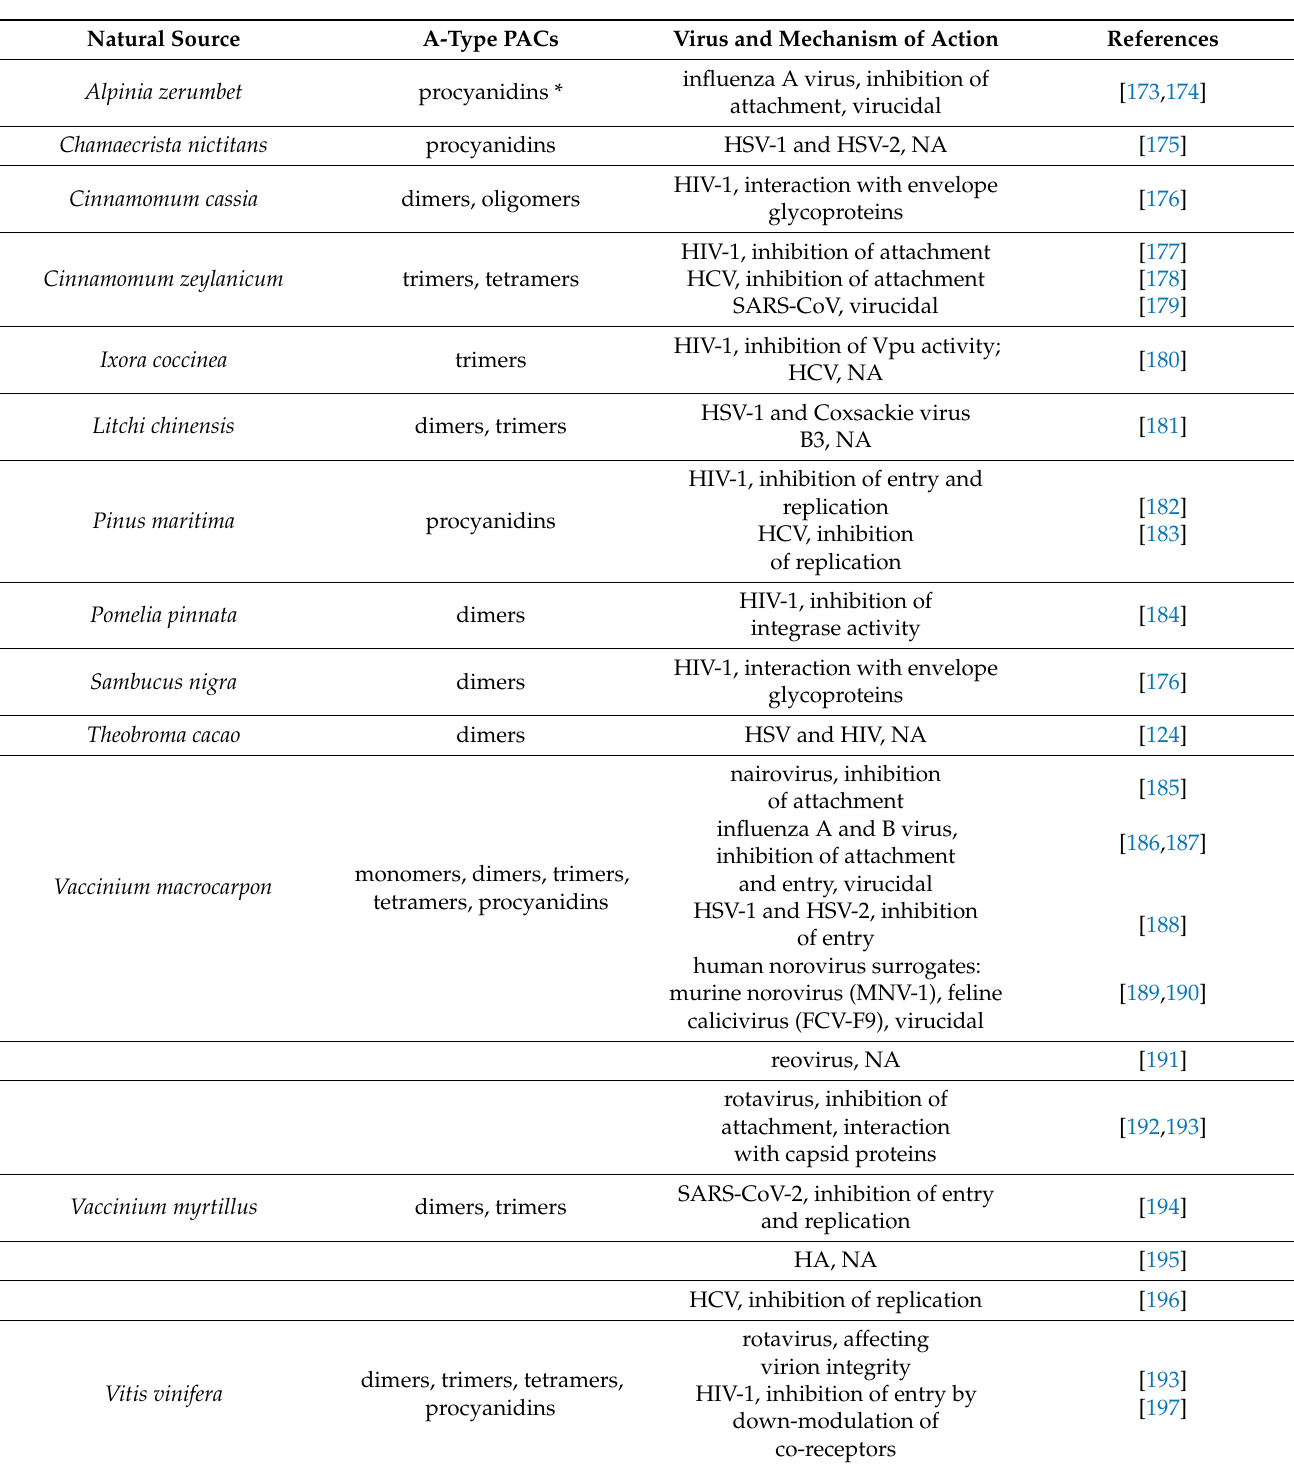
Table 2. Antiviral activity of plants-derived